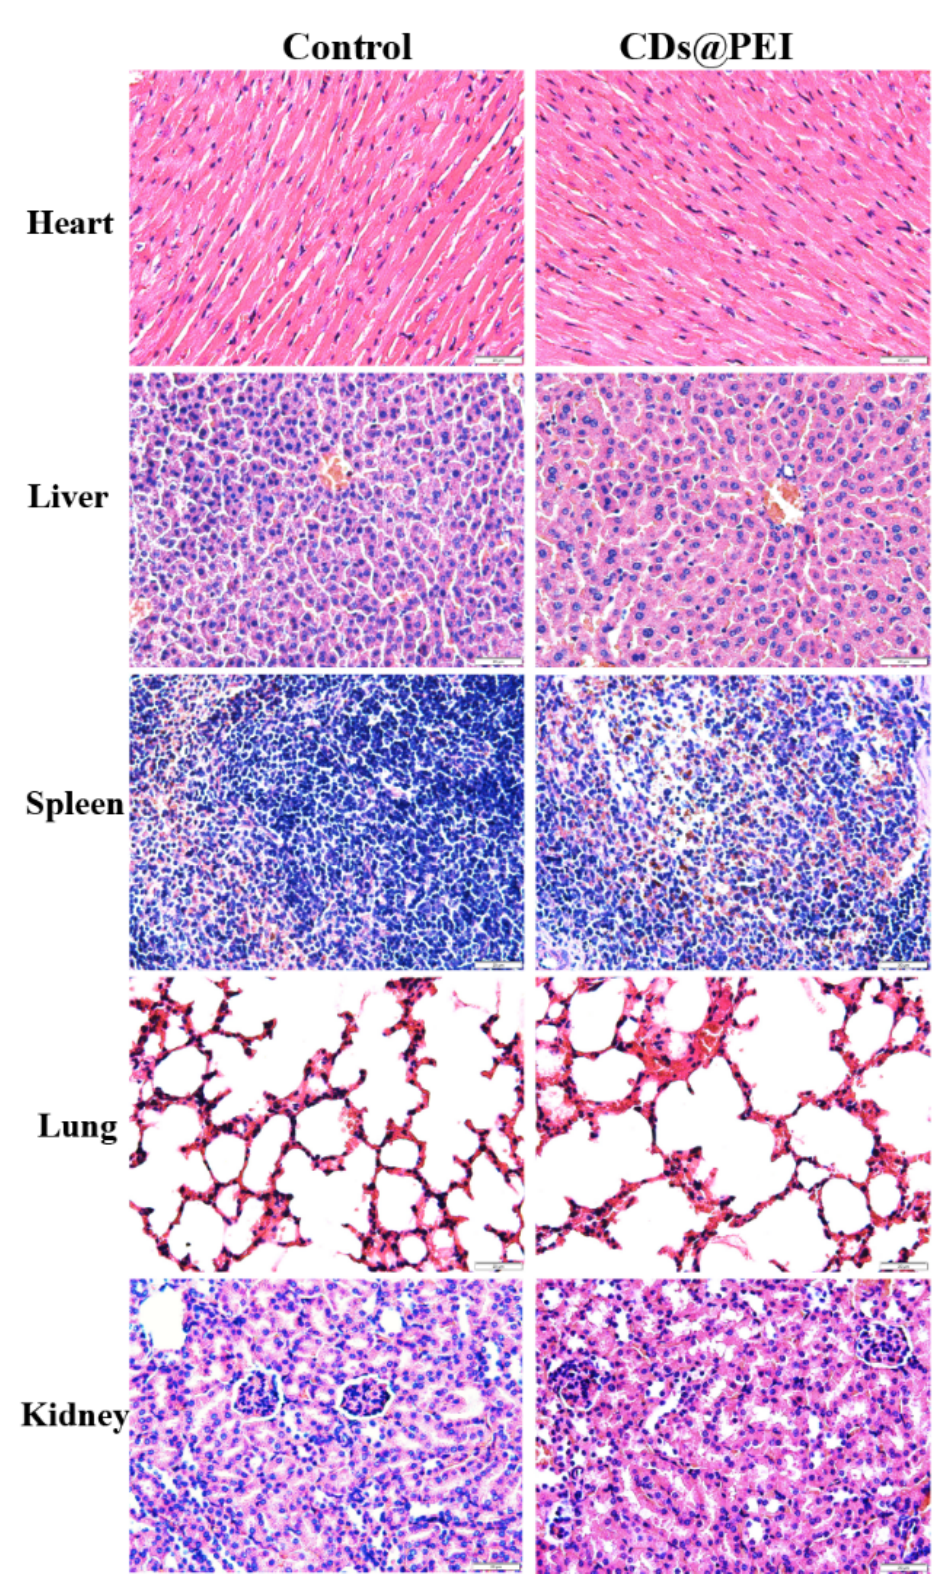
Figure 8. H&E staining from the major tissues of BALB/c mice at two weeks after injection with saline and CDs@PEI nanoparticles (scale bar = 20 μ m).